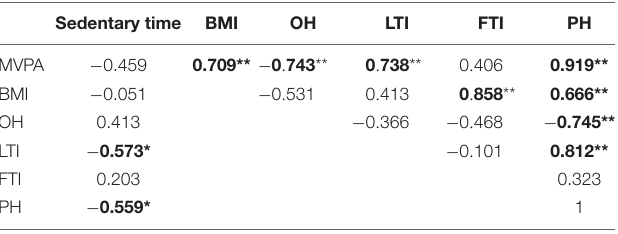
TABLE 2 | Pearson’s product-moment correlation coefficient (r) between physical activity domains and selected parameters of body composition analysis. Sedentary time BMI OH LTI FTI PH